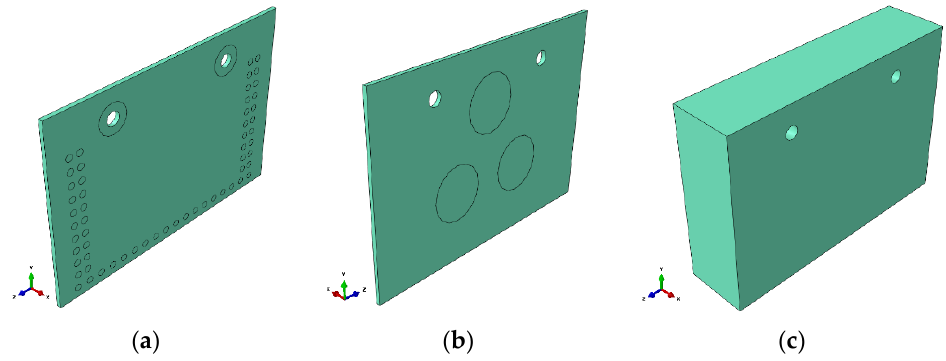
Figure 9. Anchor block element modeling for ( a ) front steel part, ( b ) rear steel part and ( c ) UHPC part.